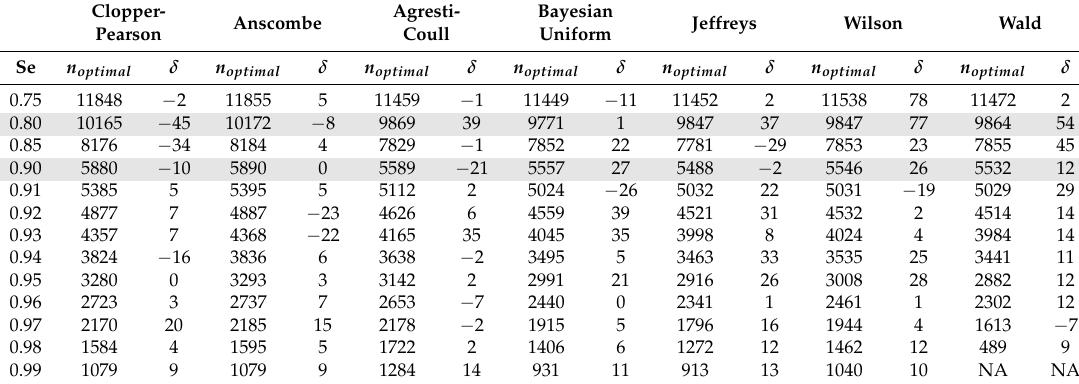
Table 1. Optimal sample sizes ( n optimal ) corresponding to several sensitivities, and differences between the optimal and approximate ( n aprox ) sample sizes, δ = n optimal − n aprox , admitting η = 0.10, ω = 0.05, ξ = 10 − 4 , and 95% nominal confidence